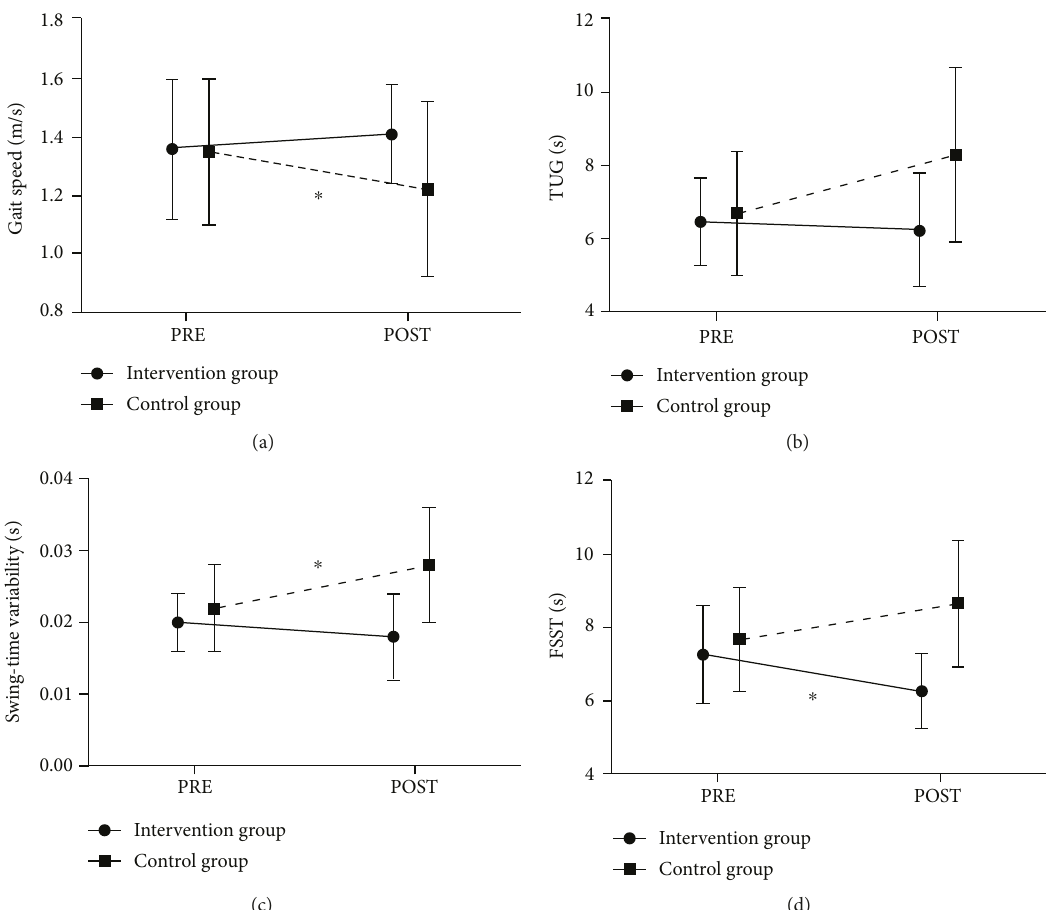
Figure 2: Results from functional locomotor outcome measures (mean ± standard deviation): (a) gait speed in the fast-paced dual-task walking condition; (b) results for the Timed Up and Go test (TUG); (c) swing-time variability in the fast-paced dual-task walking condition; (d) the results for the Four Step Square Test (FSST). Note: ∗ indicates a signi fi cant change ( p < 0 05 ) in the Bonferroni- corrected post hoc test from PRE to